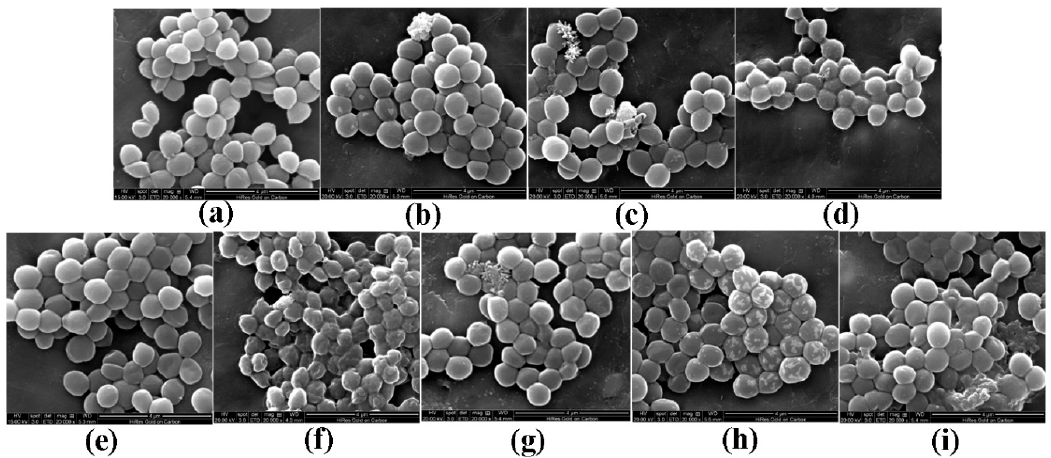
Figure 2. Scanning electron microscopy (SEM) images of morphological changes in bacteria after they were cultured with pBD2. ( a ) Control cells incubated without pBD2 for 1 h; ( b ), ( c ), and ( d ) cells were treated for 1 h with 37.5, 75, and 150 μ g/mL pBD2 respectively; ( e ) control cells incubated without pBD2 for 4 h; ( f ) and ( g ) cells were treated for 4 h with 37.5 and 75 μ g/mL pBD2, respectively; ( h ) and ( i ) cells were treated for 4 h with 150 μ g/mL pBD2.